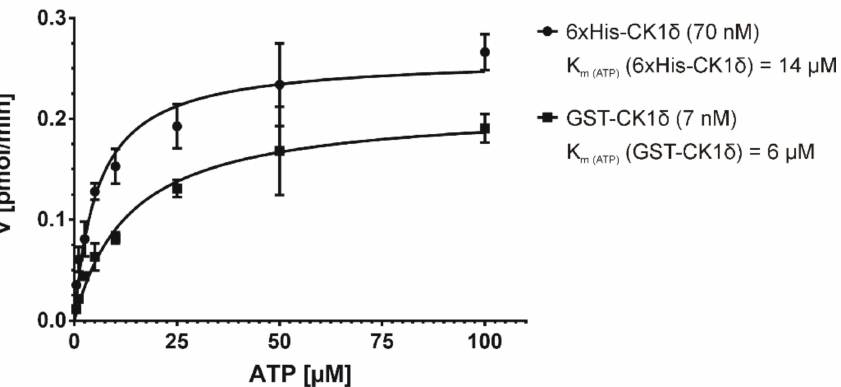
Figure 7. Michaelis-Menten kinetics for GST-CK1 δ and 6 × His-CK1 δ assayed in presence of in- creasing ATP concentrations. Initial velocity (V init ) [pmol/min] was determined at different ATP concentrations (0.5 to 100 µ M). K m (ATP) defines the concentration of the co-substrate ATP at which half of the maximal velocity (V max ) is achieved. K m (ATP) , Michaelis constant for